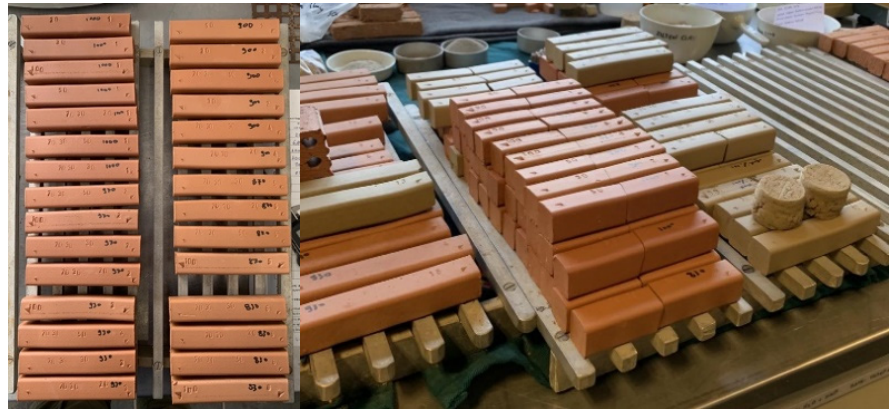
Figure 7. Fired samples for mixture EPTZ3050 before and after the evaluation of the bending strength on fired products.